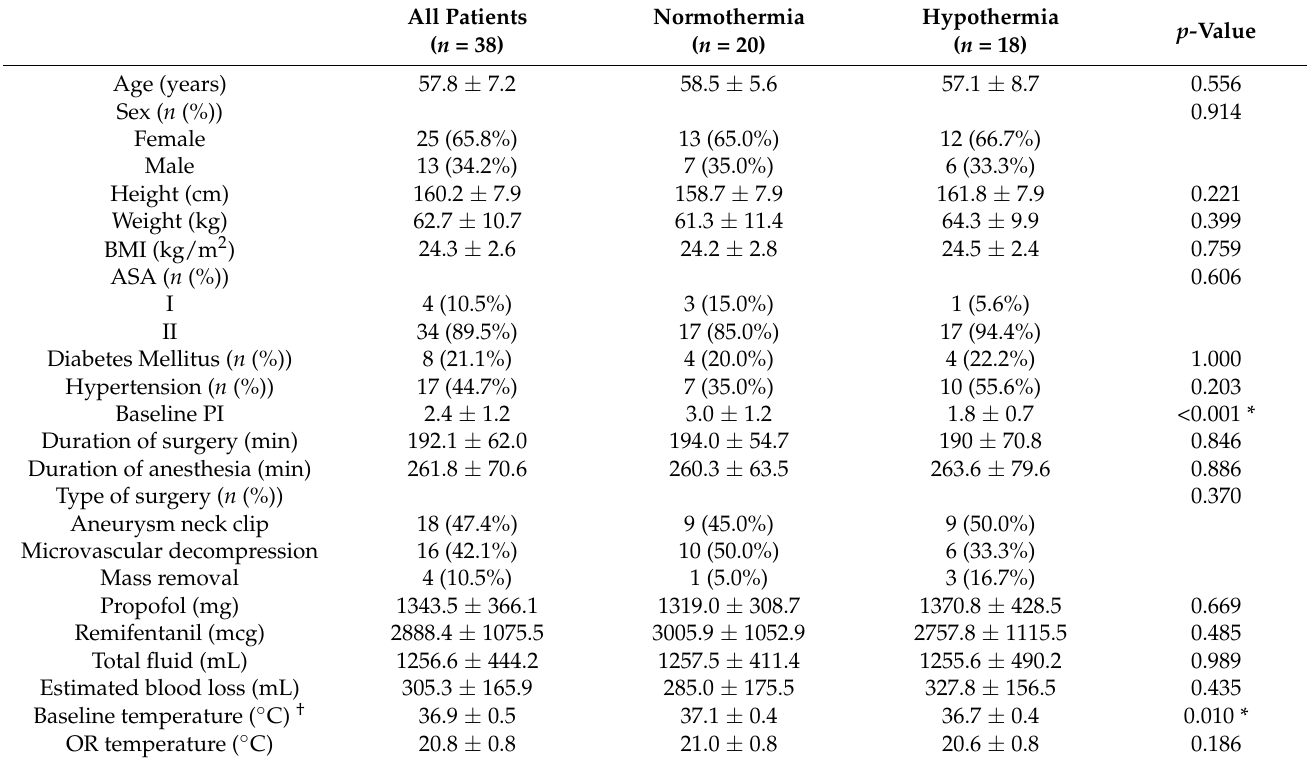
Table 1. Demographic and intraoperative data of the patients.